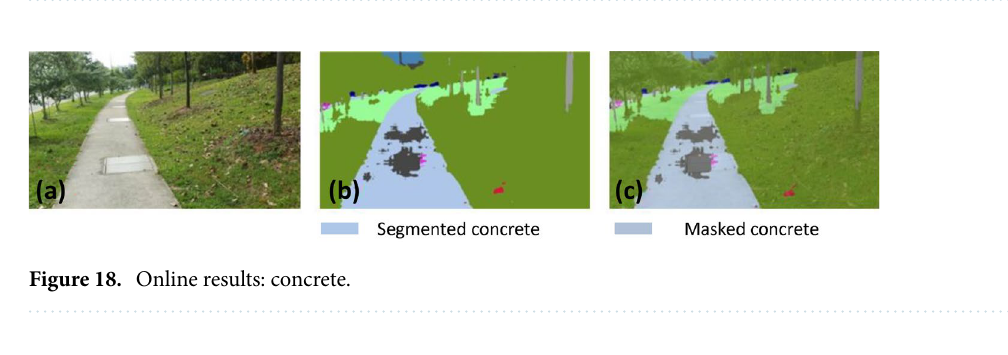
Figure 17. Online results: concrete.